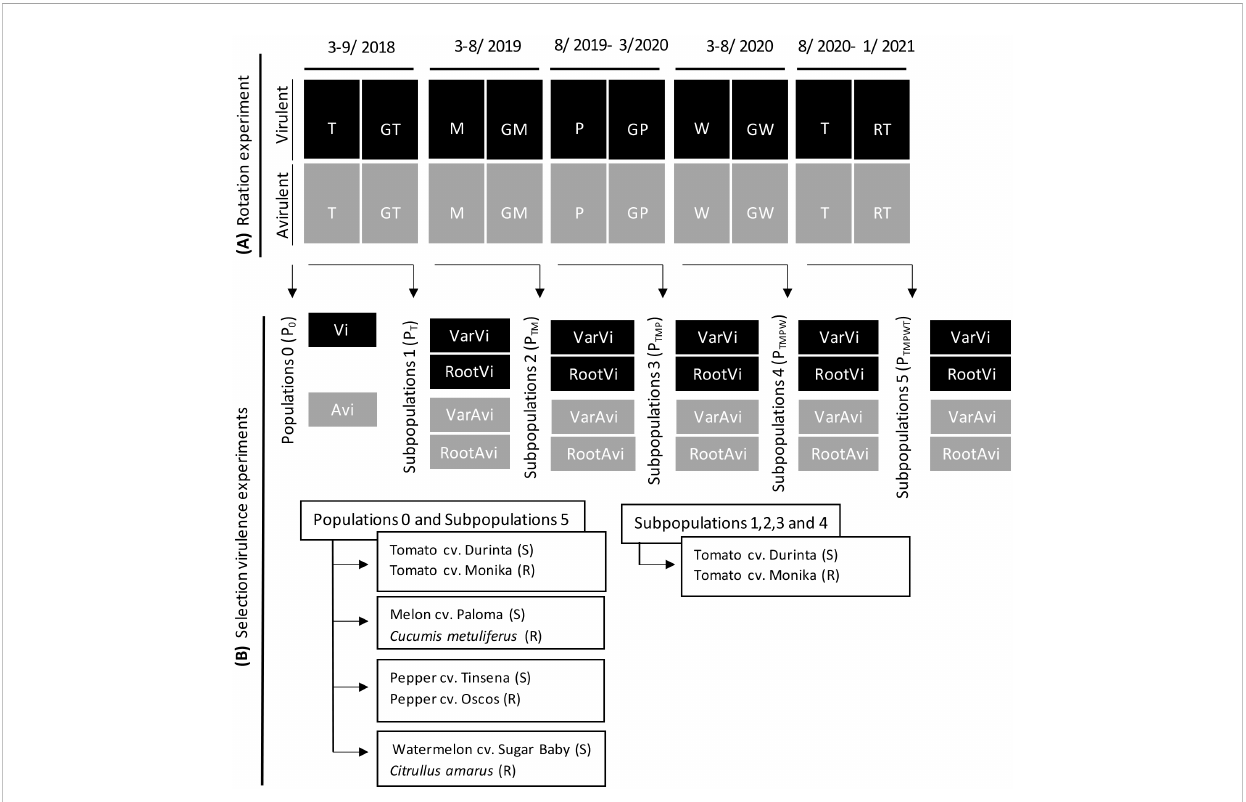
FIGURE 1 (A) Rotation schemes for ungrafted tomato (T) - melon (M) - pepper (P) - watermelon (W) or grafted onto the resistant rootstocks ‘ Brigeor ’ (GT)- Cucumis metuliferus (GM) accession BGV11135- ‘ Oscos ’ (GP)- Citrullus amarus (GW) accession BGV5167 followed by a susceptible tomato cv.